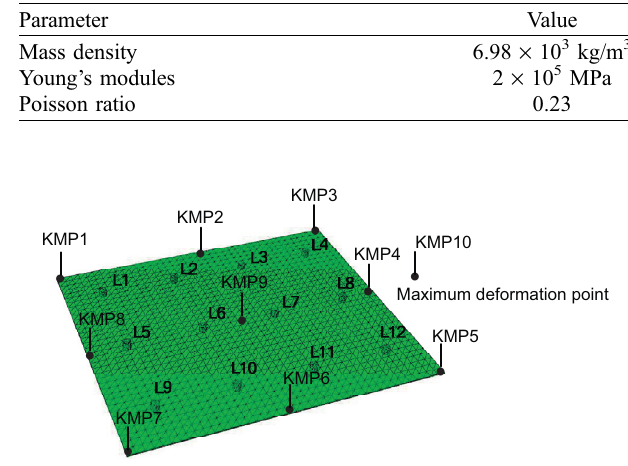
Figure 3. Mesh generation of sheet metal